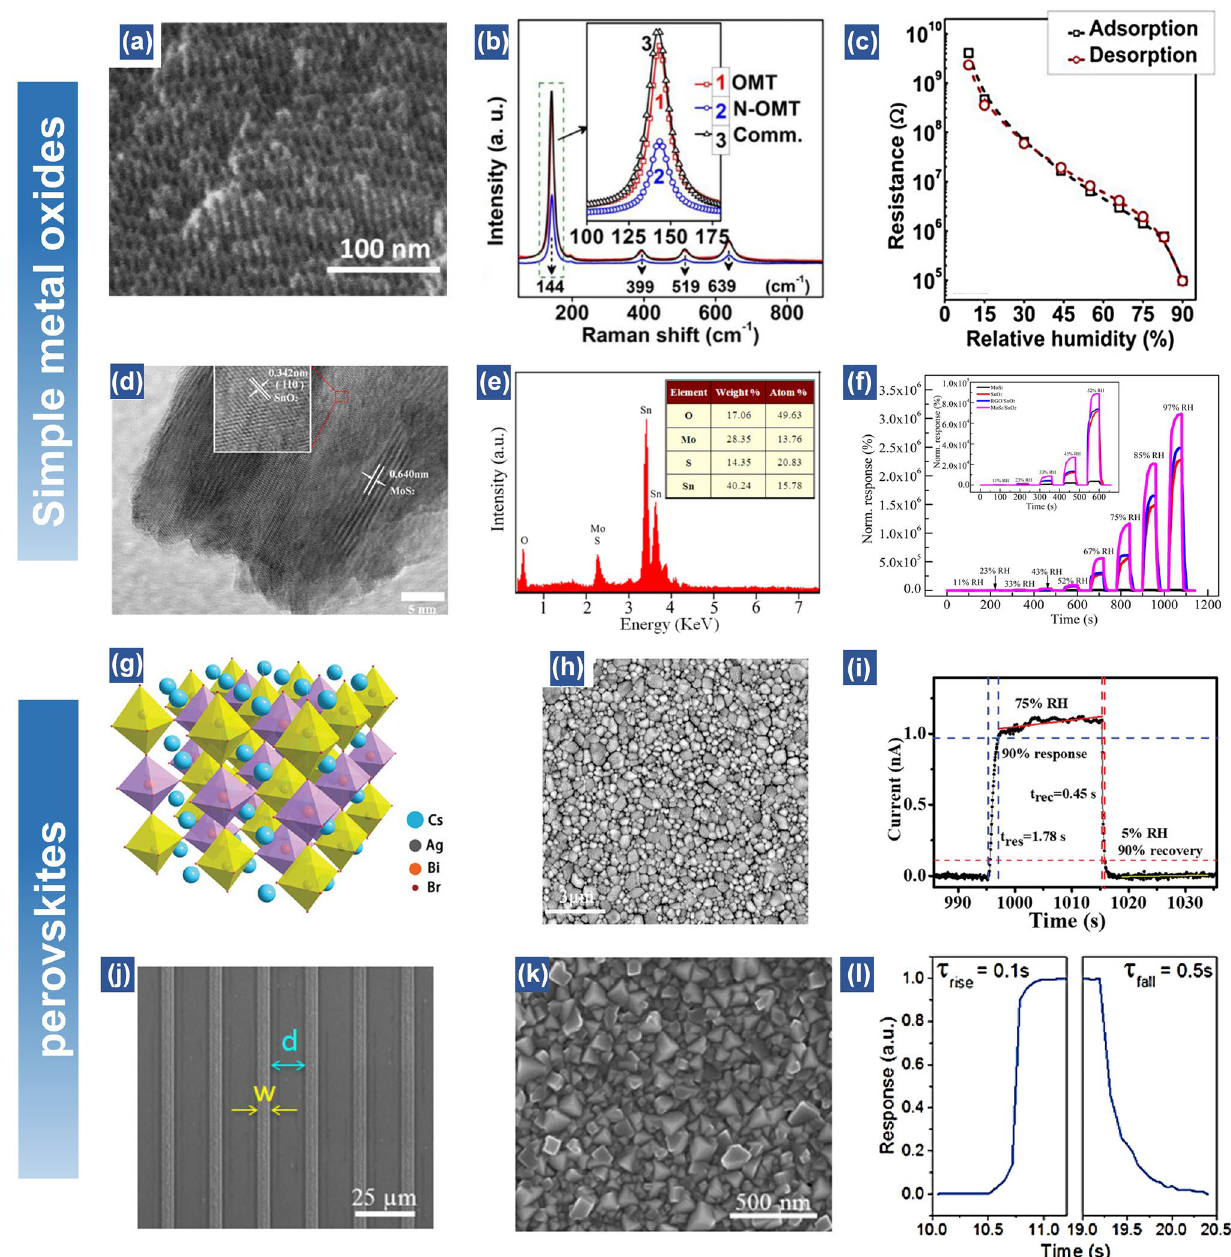
Fig. 4 Simple metal oxides-based and perovskites-based flexible humidity sensors. ( a ) SEM images of nitrogen doped ordered mesoporous TiO 2 (N-OMT). ( b ) Raman spectra of OMT, N-OMT and Commercial TiO 2 . ( c ) Hysteresis of sensor based on N-OMT [48]. Copyright 2018 Elsevier. ( d ) TEM images of MoS 2 /SnO 2 hybrid. ( e ) EDS spectrum and elemental composition of the MoS 2 /SnO 2 hybrid. ( f ) Comparative results of a MoS 2 /SnO 2 hybrid film sensor in sensing response with pure MoS 2 , pure SnO 2 , and RGO/SnO 2 hybrid film. Inset: the compar- ative normalized response of the four sensors exposed to 11 − 52% RH [78]. Copyright 2016 ACS Publications. ( g ) Schematic structure of Cs 2 BiAgBr 6 crystal. ( h ) Top-view SEM image of Cs 2 BiAgBr 6 film. ( i ) One dynamic response and recovery curve under 1 V bias [41]. Copyright 2019 Wiley. ( j ) spin-coated PbI 2 and CH 3 NH 3 PbI 3 microstripes with widths of 5 μm. ( k ) Surface of the CH 3 NH 3 PbI 3 microstripes. ( l ) Transient response at 95% RH for perovskite microstripes [69]. Copyright 2019 ACS